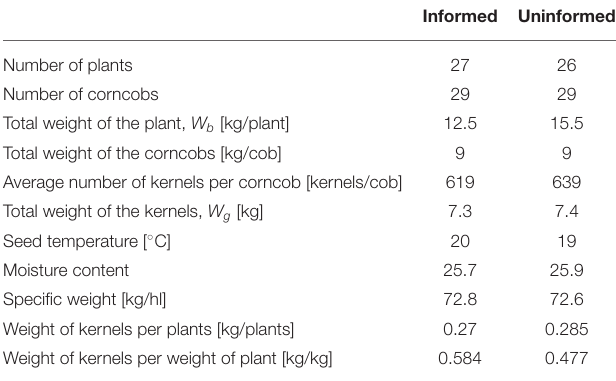
TABLE 4 | Summary of yield data.